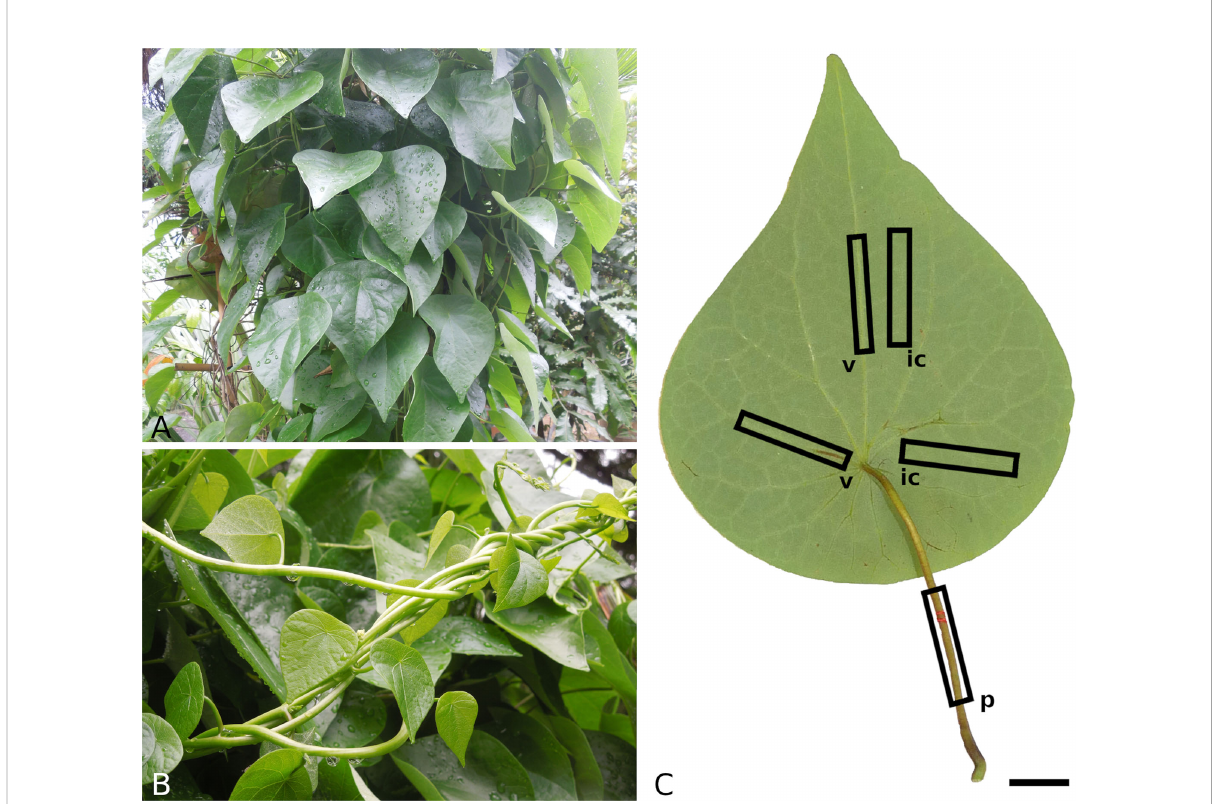
FIGURE 1 Growth habit of Stephania japonica (A, B) and sampling method for mechanical testing (C) . Petiolate leaves with a triangular-ovate to ovate lamina (A) and young climbing shoots (B) . Examplary positions and orientations of leaf samples for mechanical tests (C) , v - venation, ic - intercostal area, p - petiole, scale: 2